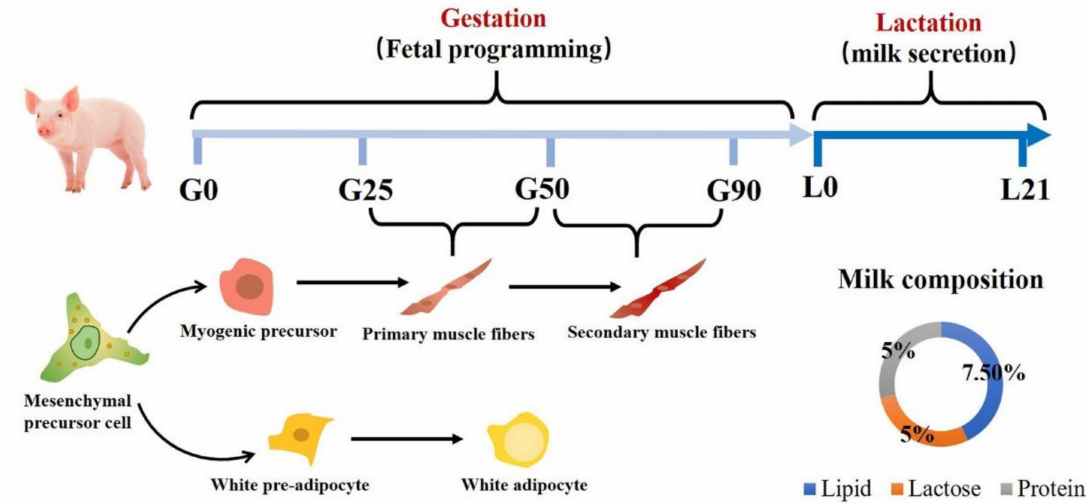
Figure 1. Maternal regulation of early development of neonates through fetal programming and